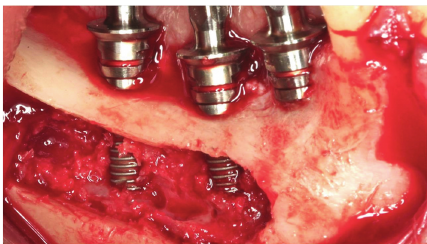
Figure 7: Installation of implants.